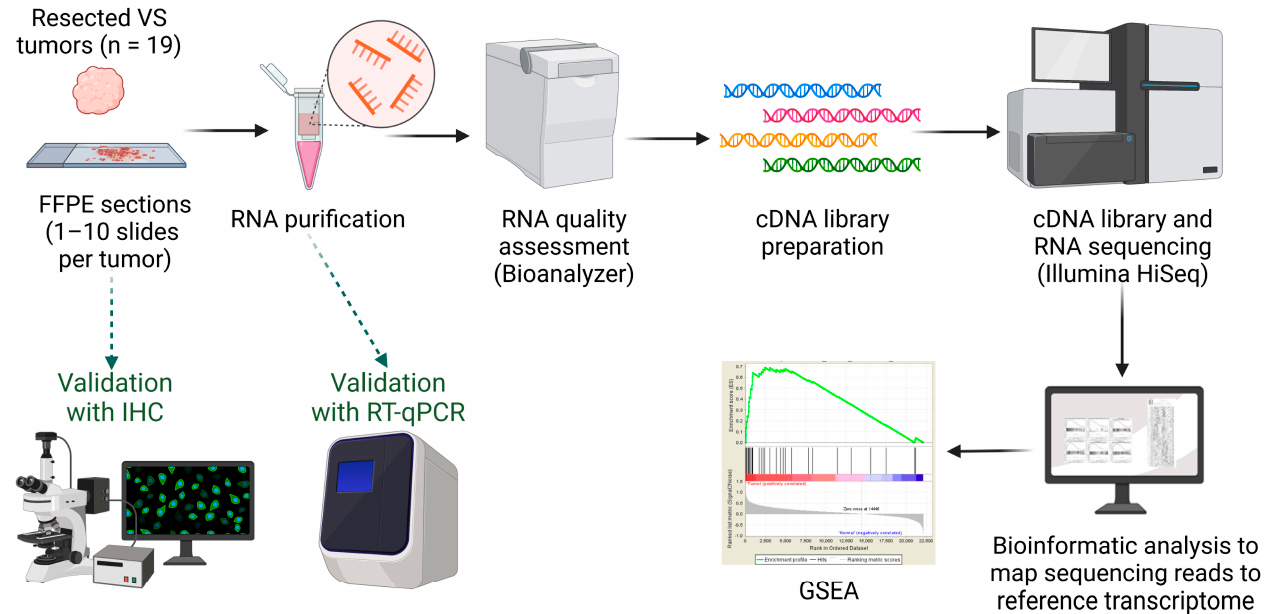
Figure 1. Methodological approach. Abbreviations: cDNA, complementary deoxyribonucleic acid; FFPE, formalin-fixed paraffin-embedded; GSEA, gene set enrichment analysis; IHC, immunohisto- chemistry; RNA, ribonucleic acid; RT-qPCR, reverse transcription–quantitative polymerase chain reaction; VS, vestibular schwannoma. Created with BioRender (www.biorender.com). Accessed on 24 March 2023.